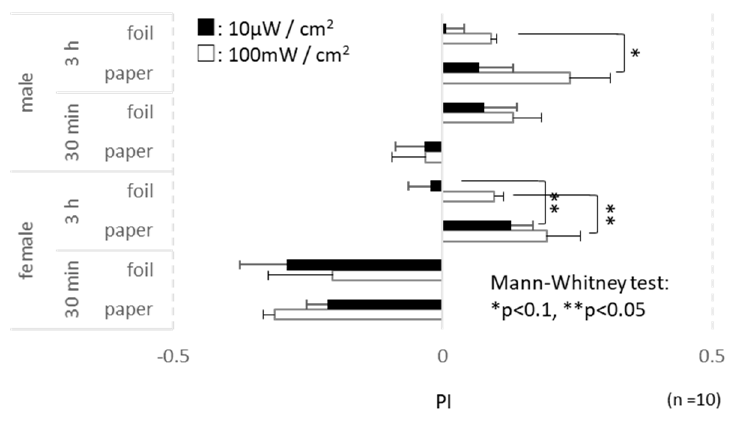
Figure 3. Performance index (PI) of flies coming out of the blue tips after 30 min / 3 h microwave irradiation in Device 4. The vertical bar indicates the test conditions, and the horizontal bar indicates the preference index (PI). A high PI score indicates the intensity of the ferret behavior, which means that more flies found the exit of the blue tip. Asterisks indicate the p value of the Mann-Whitney test. *: p < 0.1, **: p < 0.05. n = 10 for each sex.